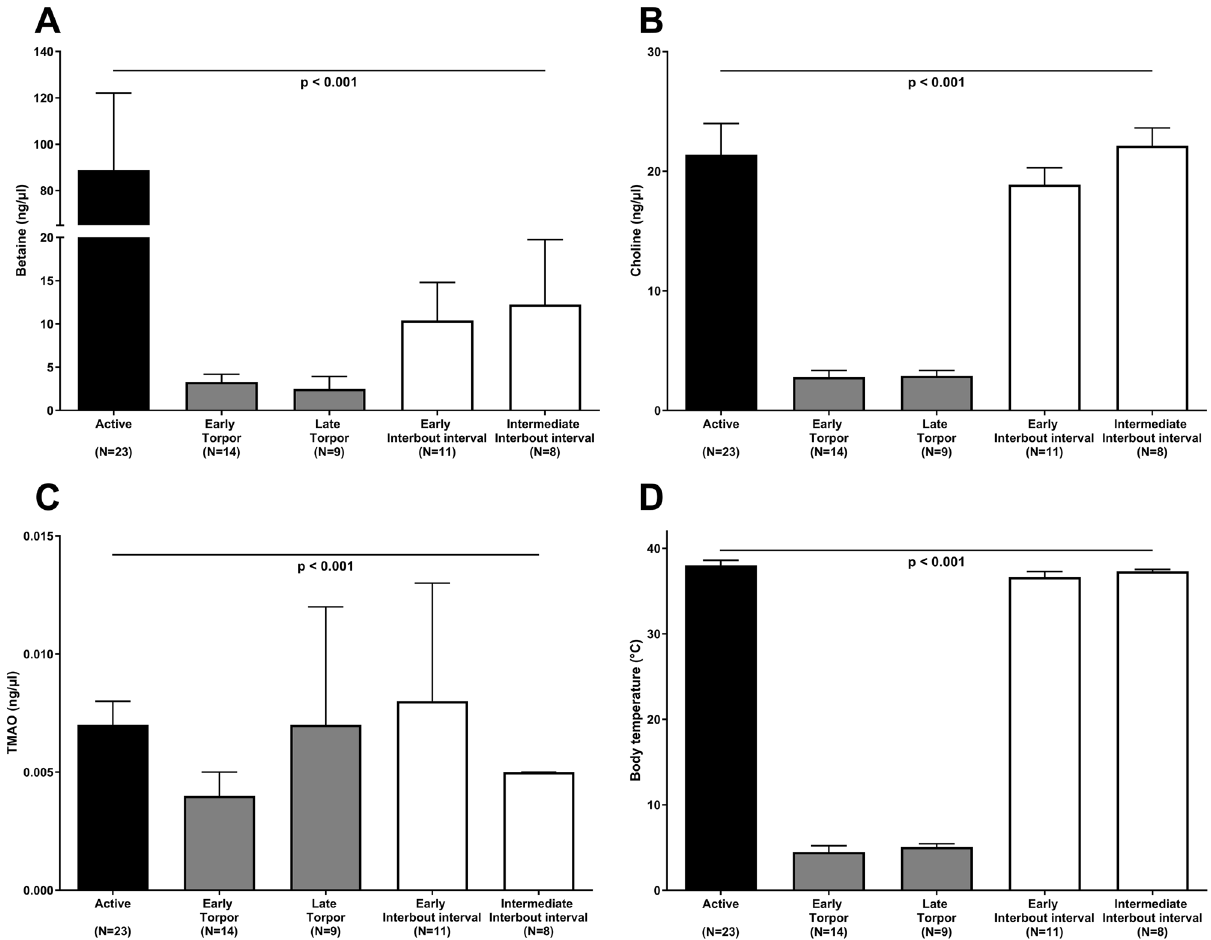
Figure 4. Circulating levels of ( A ) betaine, ( B ) choline, ( C ) trimethylamine N-oxide (TMAO), and ( D ) body temperature in garden dormice at different time points during hibernation, i.e. non-hibernation (black bars), torpor status (grey bars, stratified into early and late torpor), and interbout interval (white bars, stratified into early and intermediate interbout interval). Results are shown as median (interquartile range). Overall p values between the five groups were assessed by non-parametric Kruskal–Wallis test. Group-wise comparisons using Bonferroni post hoc analysis are described in the Results section. Number of animals included in each group is